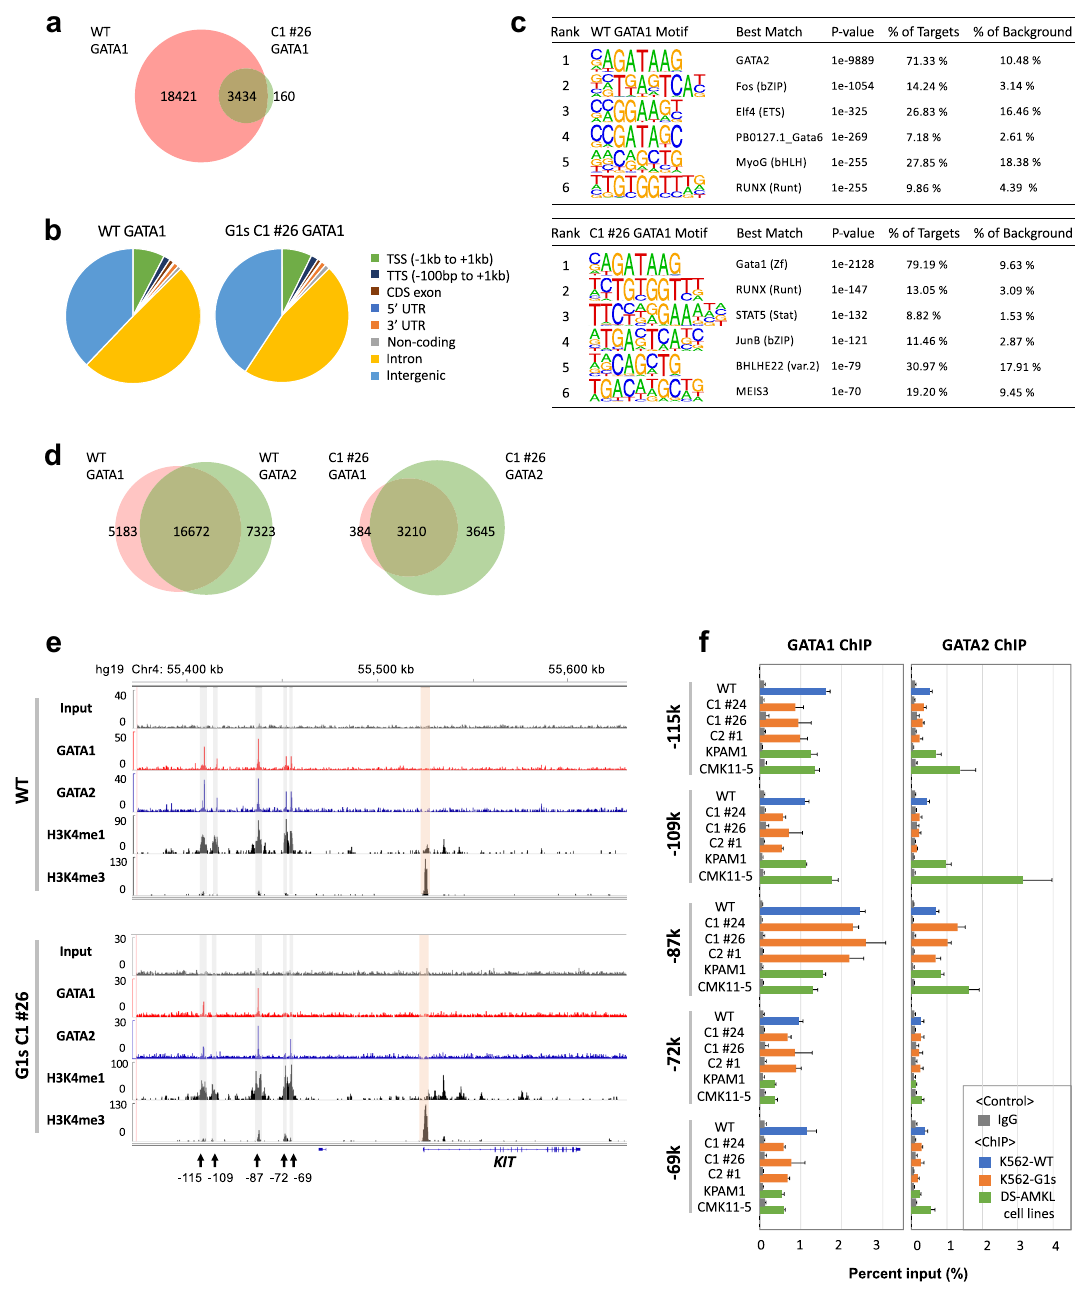
Figure 3. ChIP analysis of GATA1 and GATA2 in K562-WT and K562-G1s clones. ( a ) Overlap of peaks in GATA1 ChIP-seq of K562-WT and G1s C1 # 26. ( b ) Relative distribution of GATA1 ChIP-seq peak regions in the genome. ( c ) Results of de novo motif analysis of GATA1 ChIP-seq data. The top six motifs are shown. ( d ) Overlap of ChIP-seq peaks of GATA1 and GATA2 in K562-WT (left) and in G1s C1 #26 (right). Since both K562-WT and C1#26 had low yields of ChIP for GATA2, one library from each of the four experimental samples was prepared and sequenced. ( e ) Genome browser view at the KIT locus. The y axis shows read coverages normalized to RPGC (Read per genomic content). Light gray boxes indicate active distal regions (− 115 kb, − 109 kb, − 87 kb, − 72 kb and − 69 kb) marked with arrows, and the promoter region is highlighted in orange. The top shows profiles of K562-WT and the bottom shows profiles of the K562-G1s C1 #26. ( f ) Quantification of GATA1 and GATA2 binding upstream of KIT by ChIP-qPCR. (Left) data of GATA1 ChIP- qPCR, (right) data of GATA2 ChIP-qPCR. Results are averages of three independent experiments. Error bars represent standard